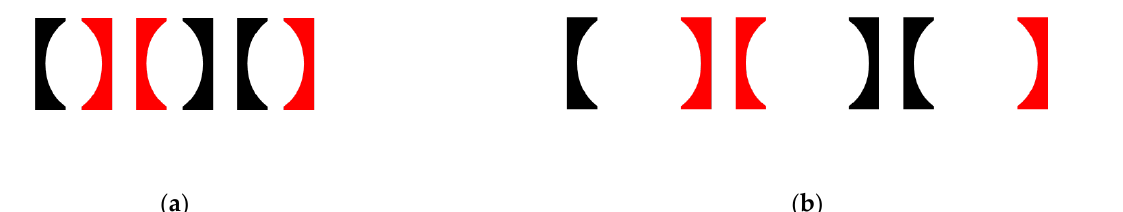
Figure 10. Competitive relationship between law of closure and law of proximity. ( a ) Law of closure is stronger than law of